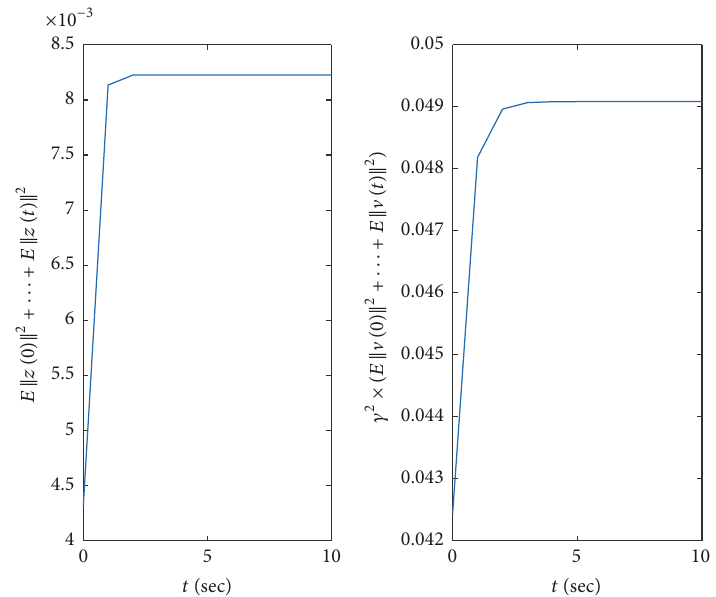
Figure 3: 𝐻 ∞ performance analysis: the closed-loop system (28) without external